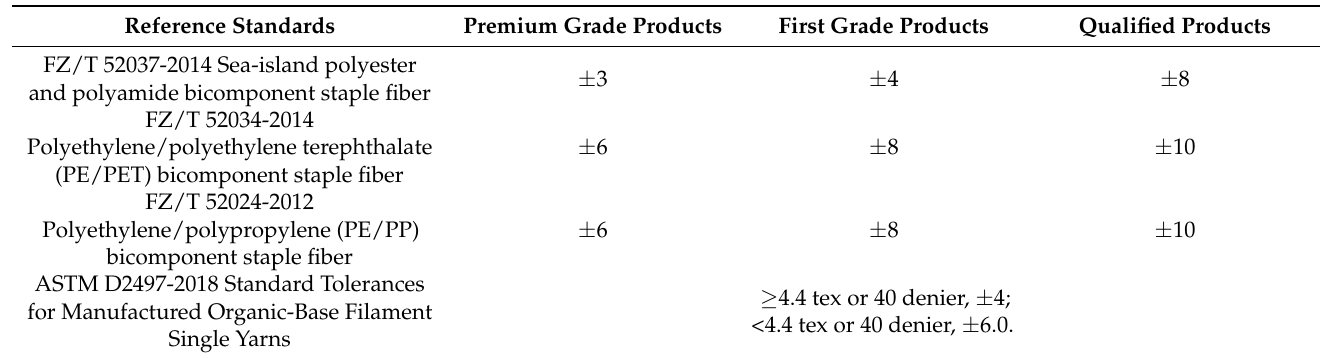
Table 1. Allowable deviation rate of linear density of the chemical fiber in relevant standards ( E , %).